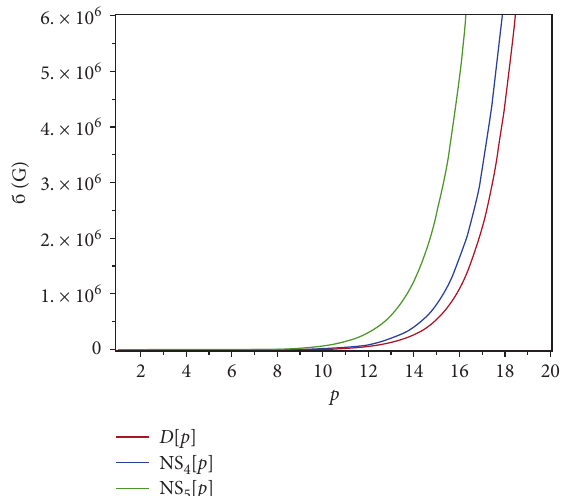
Figure 9: Curves of irregularity index IRR